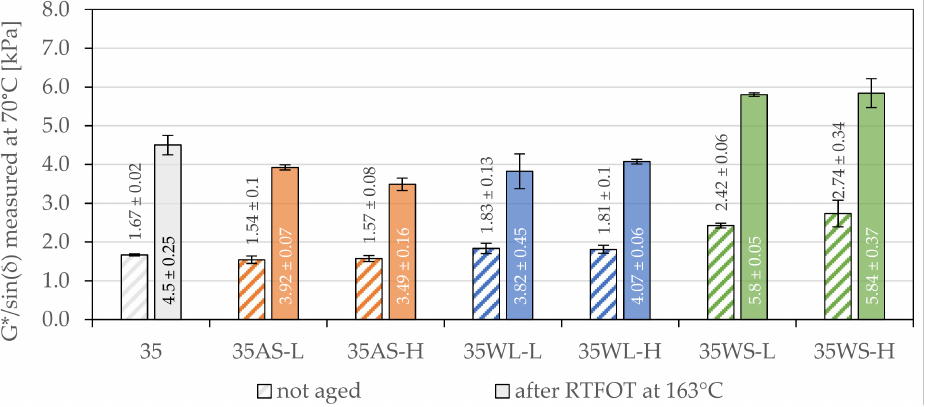
Figure 5. High-temperature stiffness of the investigated asphalt binders based on the 35/50-penetration bitumen.